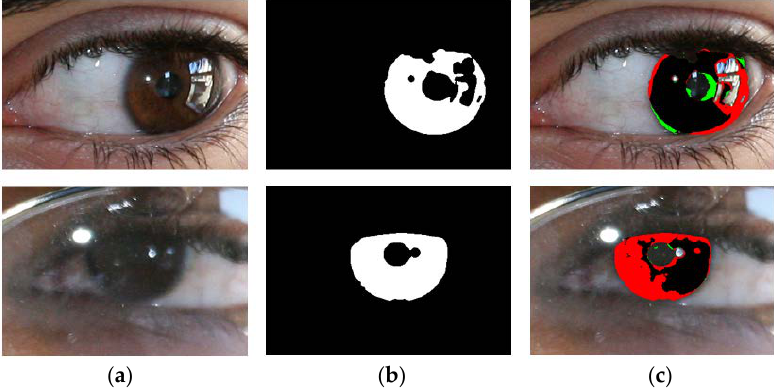
Figure 9. Examples of incorrect iris segmentation by our method. ( a ) Original input images. ( b ) Ground-truth images. ( c ) Segmentation results (The false positive and negative errors are presented as green and red, respectively. The true positive case is shown in black).